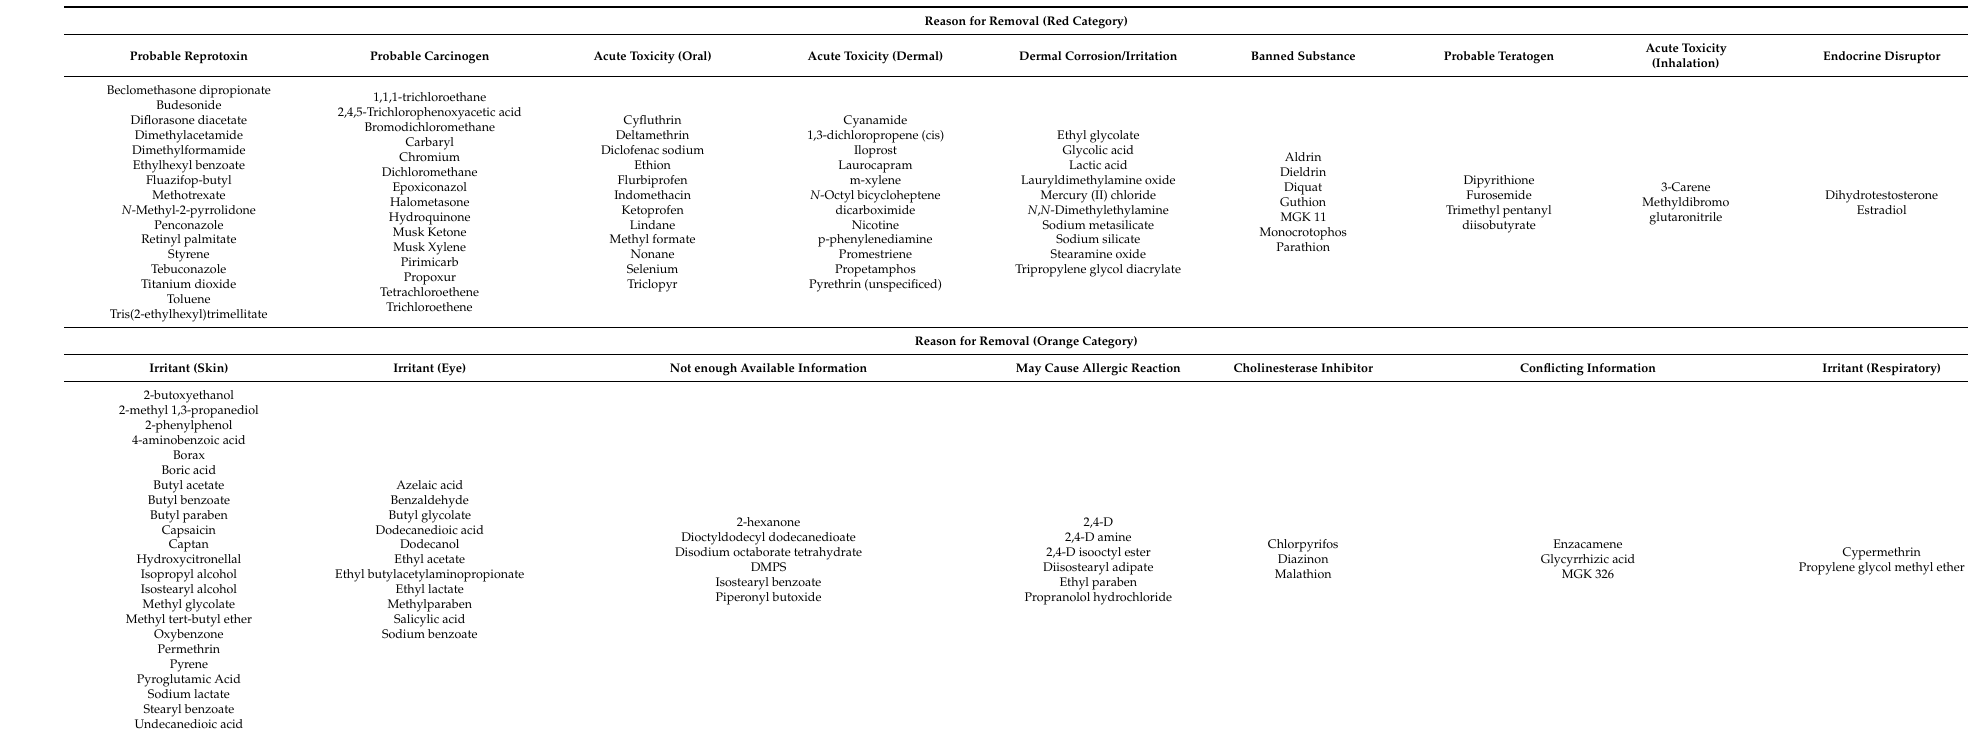
Table 3. Red and orange category chemicals and their primary reason for